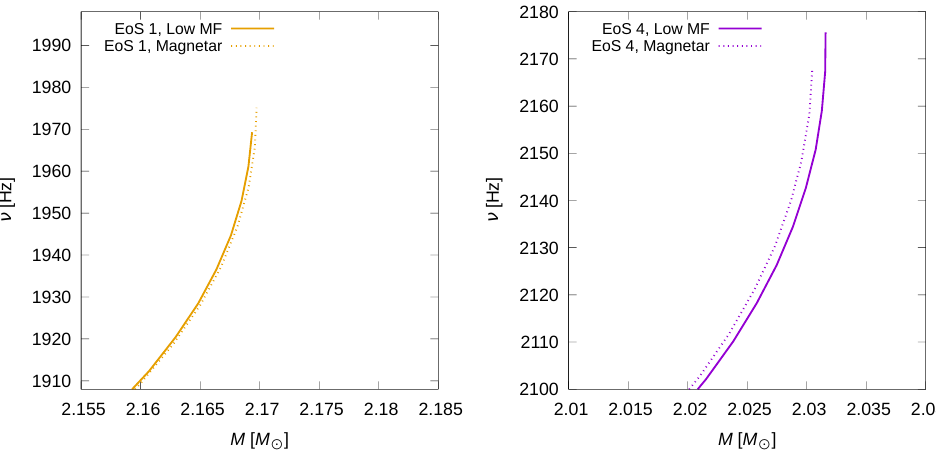
Figure 8. Enlarged zoomed-in view of the frequency–mass relationships for the sets of Table 2. Continuous (dotted) curves represent low-MF (magnetars) QSs. The effect of the MF is negligible; as we already pointed out in the mass–radius relationship, the QS families constructed using EoSs 1 and 4 are more sensitive to the variation of the MF